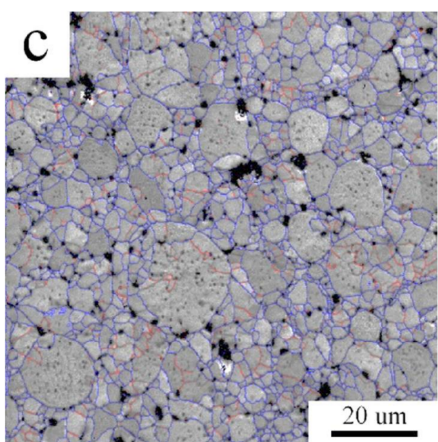
Figure 12. The microstructure of the Al7075_AC_HT compact (annealed 425 ◦ C/1 h): ( a ) BSE contrast image; ( b ) EBSD inverse pole figure; ( c ) distribution of grain boundaries, boundaries with misorientation angles above 15 ◦ in blue, boundaries between 5 ◦ and 15 ◦ in red.